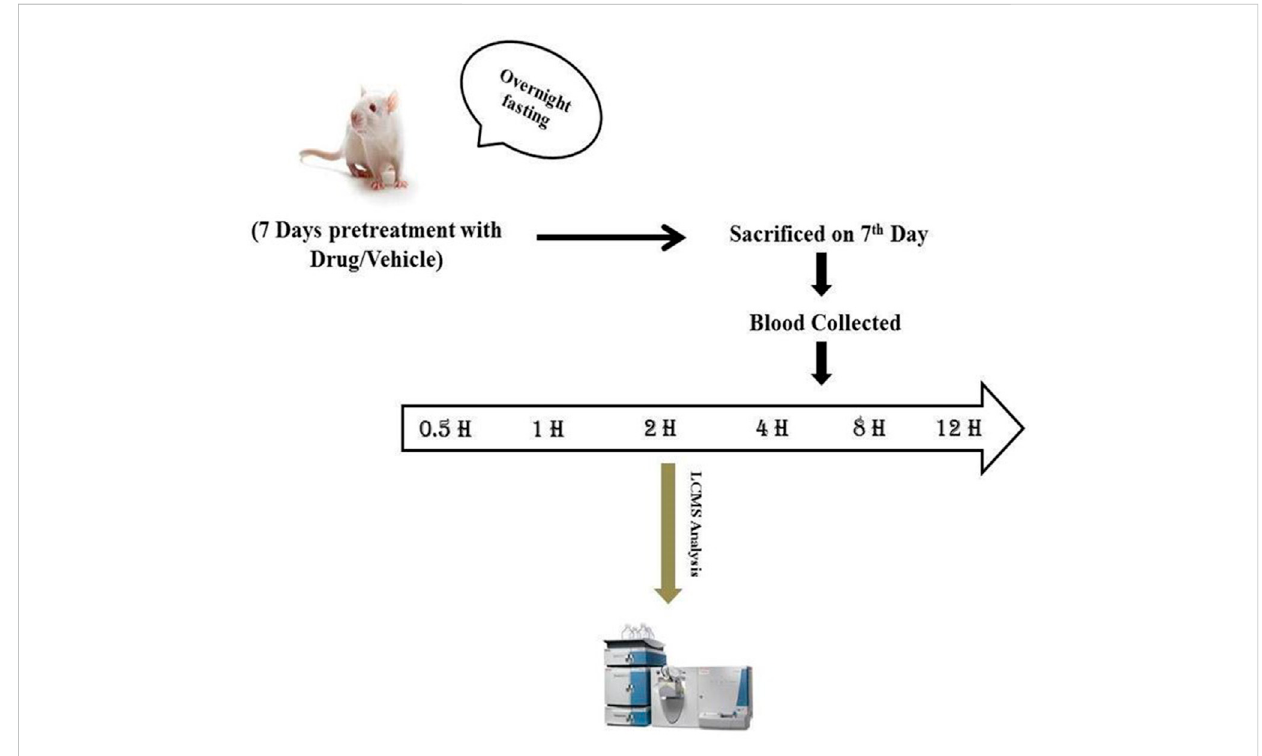
FIGURE 2 Experimental design for pharmacokinetics study. Sample blood collection at regular intervals (0, 0.5, 1, 2, 4, 8, 12, and 24 h).